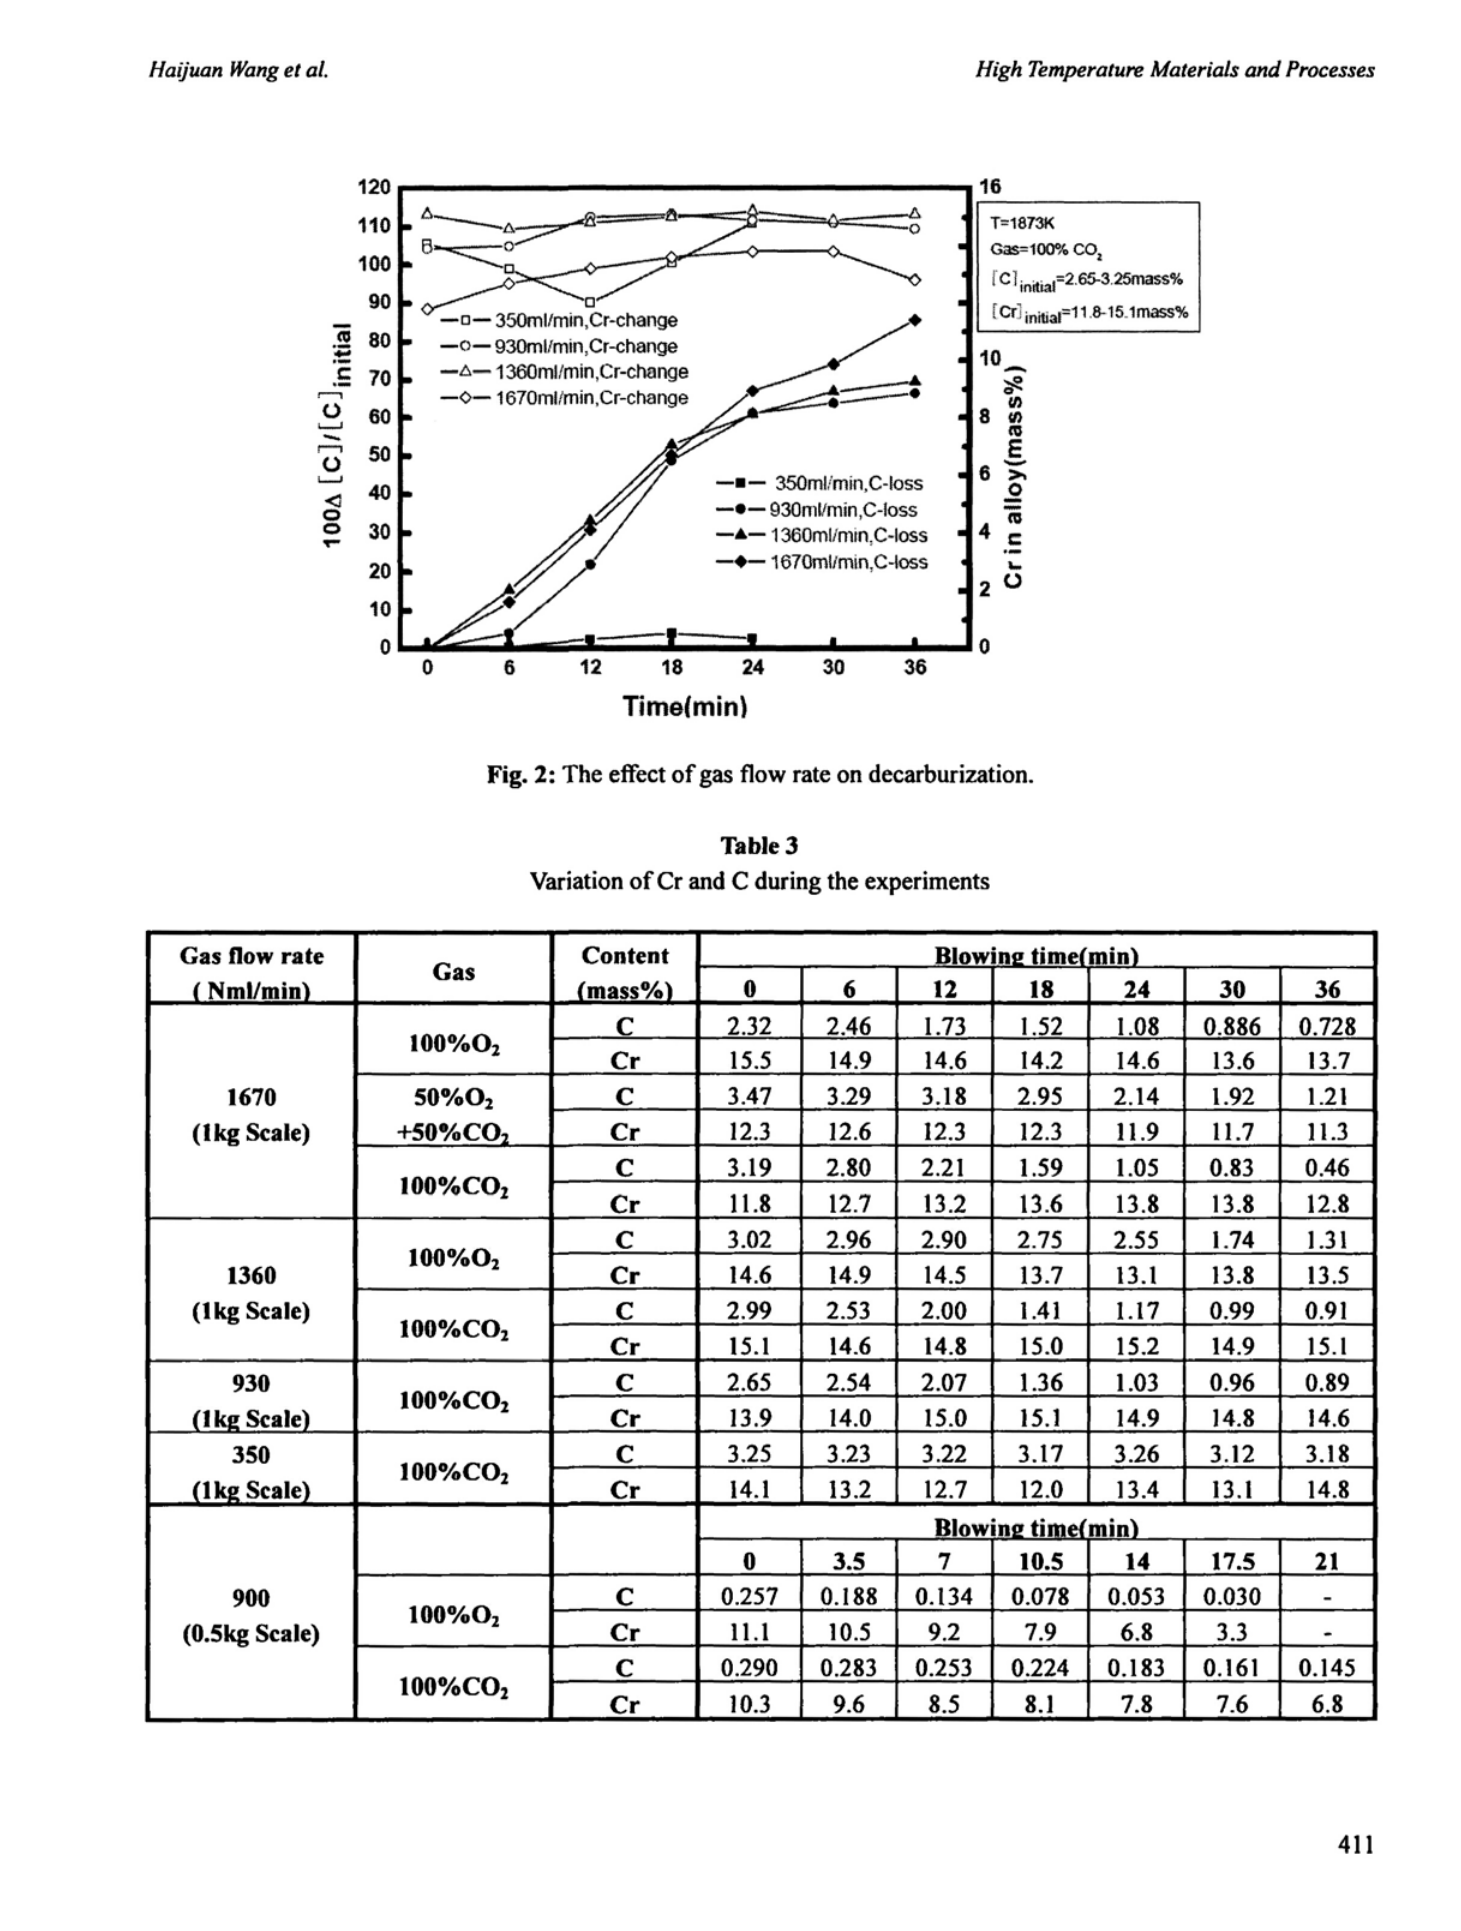
Fig. 2: The effect of gas flow rate on